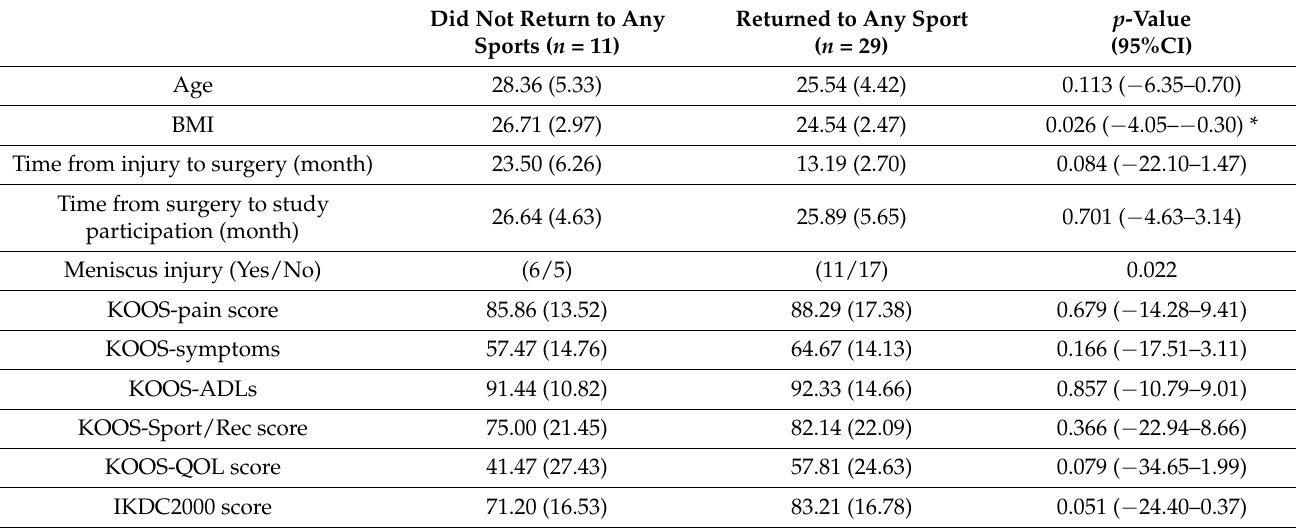
Table 1. Demographic characteristics, KOOS subscales, and IKDC2000 of athletes who did and did not return to any sports groups 2 years after ACLR (Means